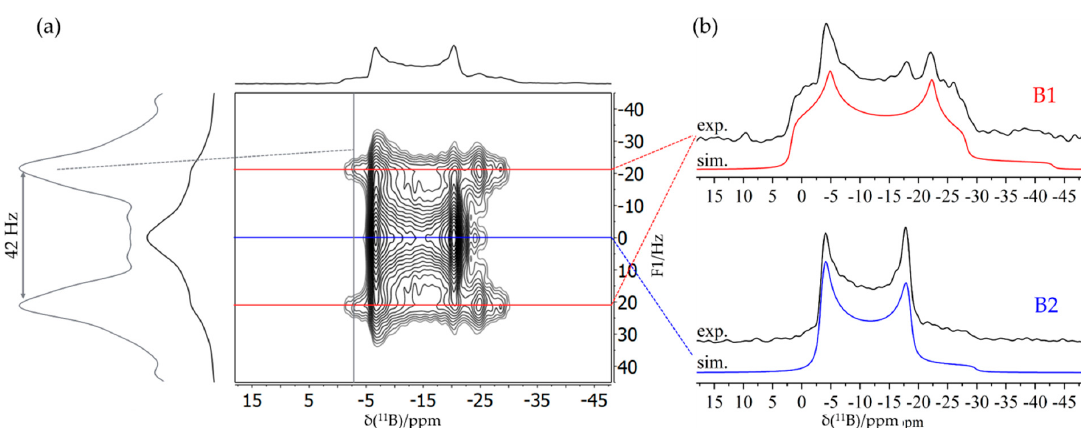
Figure 26. ( a ) The 2D 11 B{ 31 P} heteronuclear J-resolved MAS NMR spectrum of 8 . In addition to the positive projections of the indirect dimension, the column extracted at − 2.5 ppm is depicted on the left-hand side. A comparison of these show that the species B1 shows J-coupling with 31 P nuclei, characterized by an isotropic coupling constant of 42 Hz, while no J-coupling is observed for species B2. Hence, the 2D experiment can be used to resolve both species. This is demonstrated in ( b ), showing the sum of rows extracted at − 21 Hz and 21 Hz for species B1 and the row extracted at 0 Hz for B2.